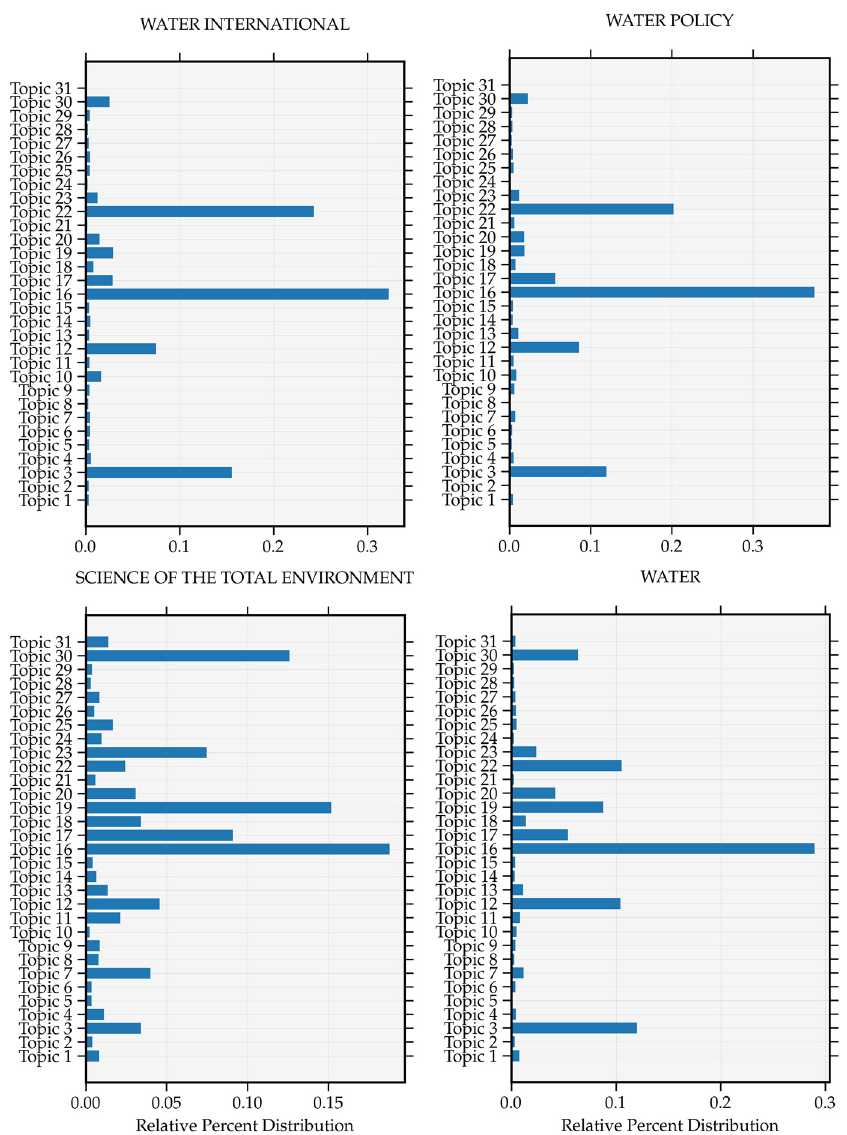
Figure 5. Topic salience across top four journals, 1990–2020.